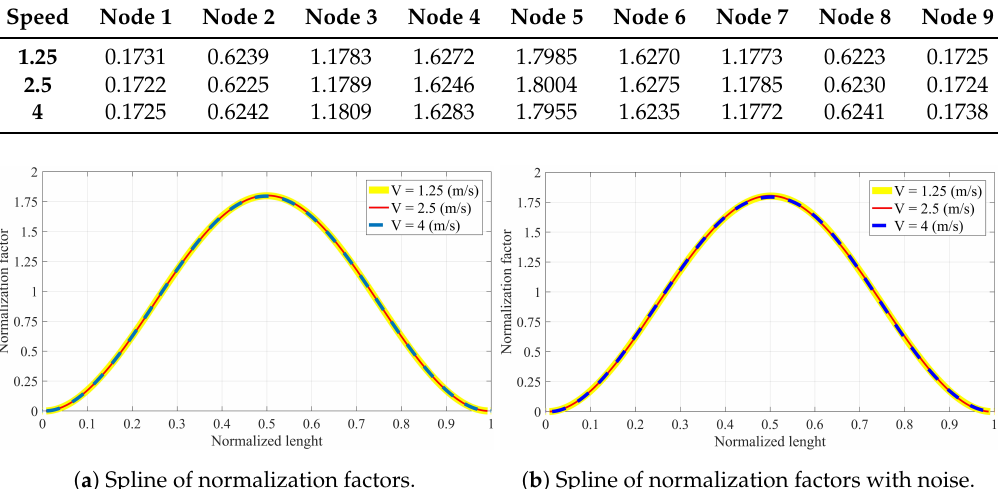
Figure 15. Splines of normalization factors along the non-damaged simply supported beam related to different velocities: ( a ) Without noise and ( b ) with 20%